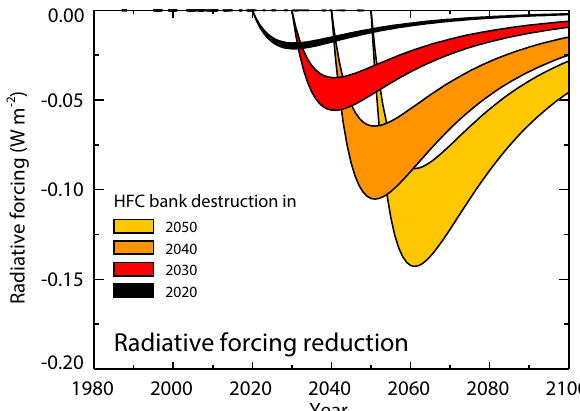
Fig. 5. Reductions in radiative forcing from destruction of the HFC banks in 2020, 2030, 2040, or 2050 relative to the case with only a production phaseout in that same year. This is equivalent to the radiative forcing contribution from the HFC bank post-2020, -2030, -2040, and -2050 in the production-phaseout scenarios. This reduc- tion plus the production phaseout gives the maximum possible mit- igation, i.e., the zero emissions scenario. The ranges correspond to the upper and lower HFC reference scenarios from Velders et al.